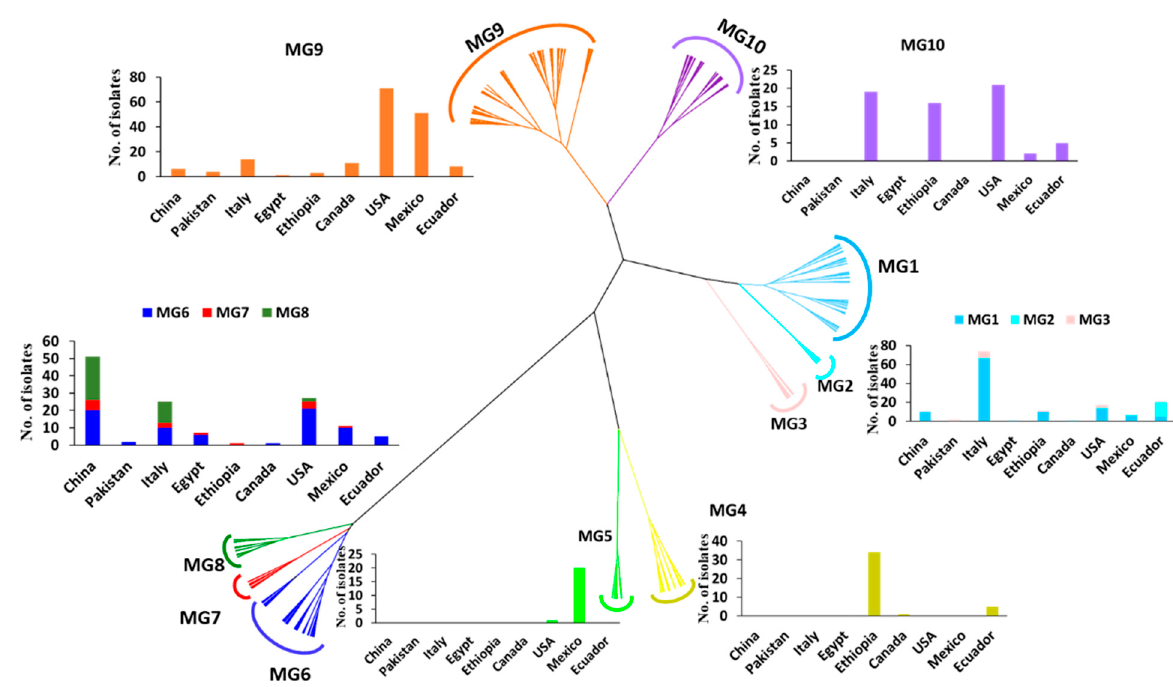
Figure 2. Dendrogram of Puccinia striiformis f. sp. tritici populations from nine countries constructed based on dissimilarities assessed with 14 simple sequence repeat (SSR) markers using the hierarchical cluster analysis, showing ten molecular groups (MGs) and the histograms with isolate numbers from different countries within each MG.